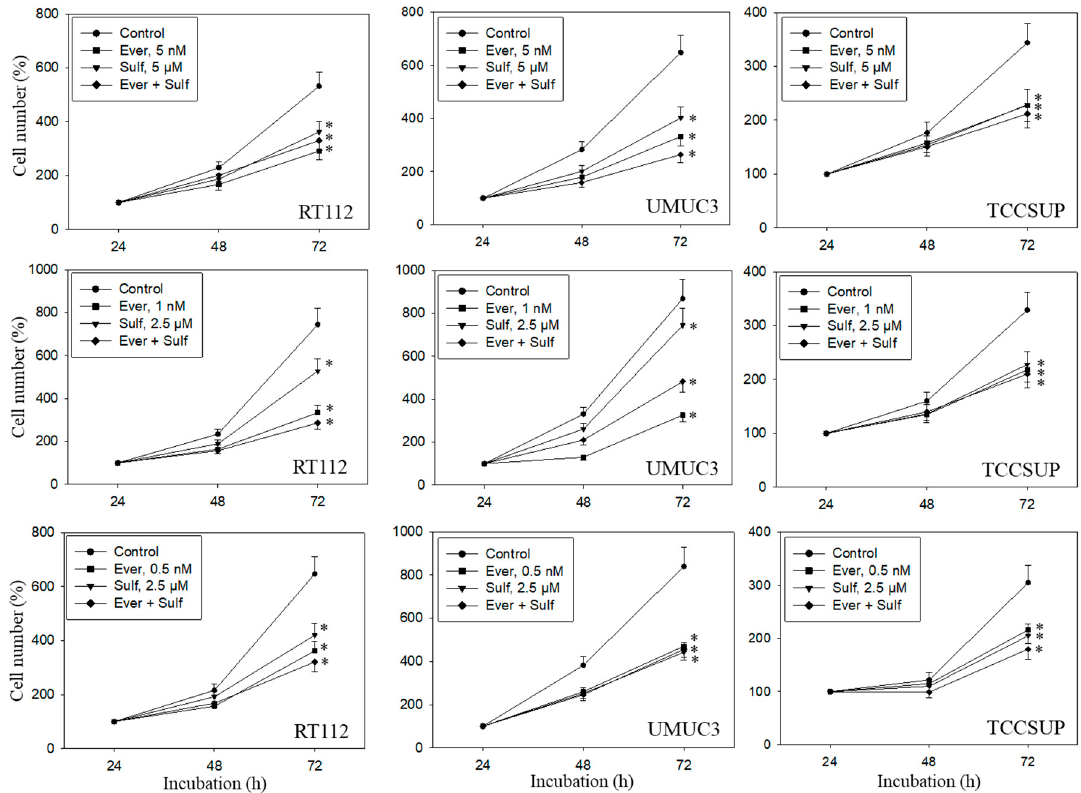
Figure 1. Cell number in response to everolimus (Ever- 5, 1, or 0.5 nM), sulforaphane (Sulf- 5, 2.5 µM), or (Ever + Sulf) under short-term application in bladder cancer cell lines RT112, UMUC3, and TCCSUP. Untreated cells served as controls. Cell number was evaluated after 24 (100%), 48, and 72 h by the MTT assay. Bars indicate standard deviation. Experiments were repeated five times. * indicates significant difference to untreated controls, p ≤ 0.05.